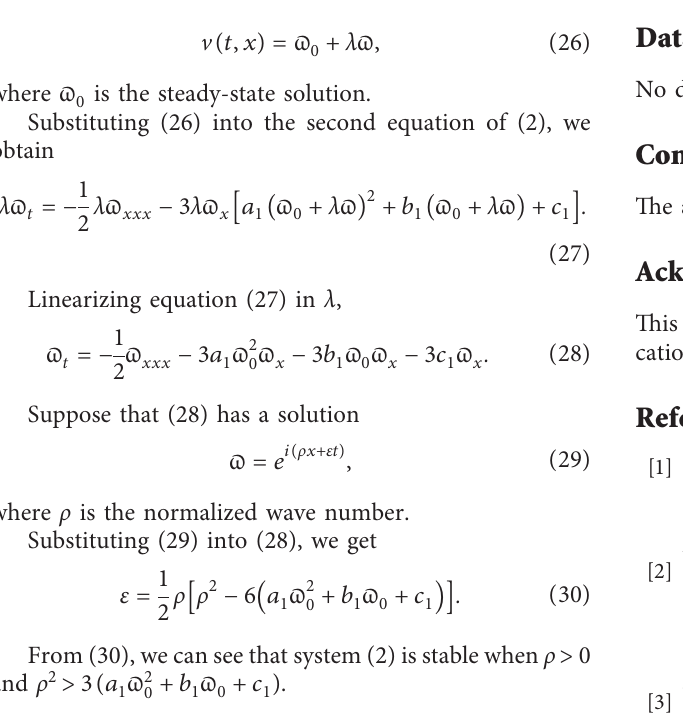
� 0, b � 3, c � 1, and c � 2. 0 1 1